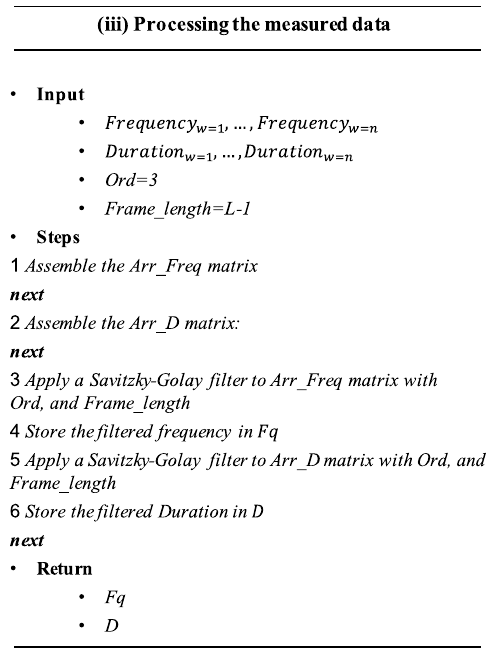
Figure 4. Pseudo-algorithm of step iii.